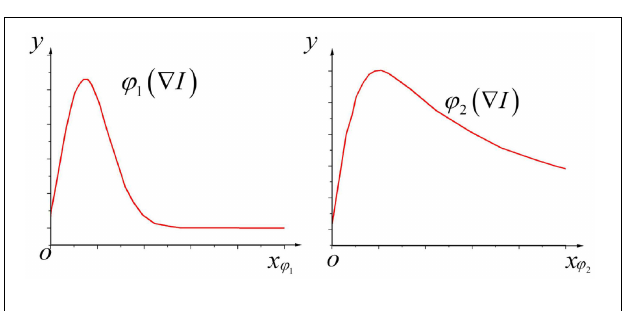
FIGURE 3 | Characteristic curves of stream functions corresponding to diffusion coefficients c